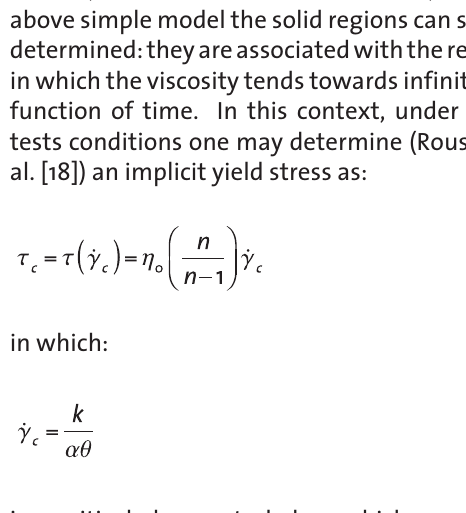
Figure 1: Inclined plane flow